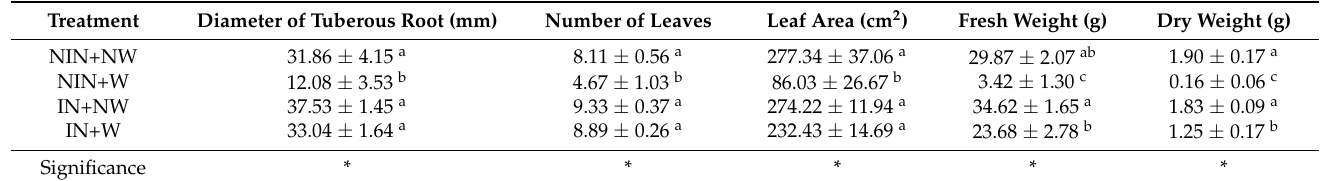
Table 2. Effect of inoculation with A. brasilense on the growth parameters of radish under waterlogging